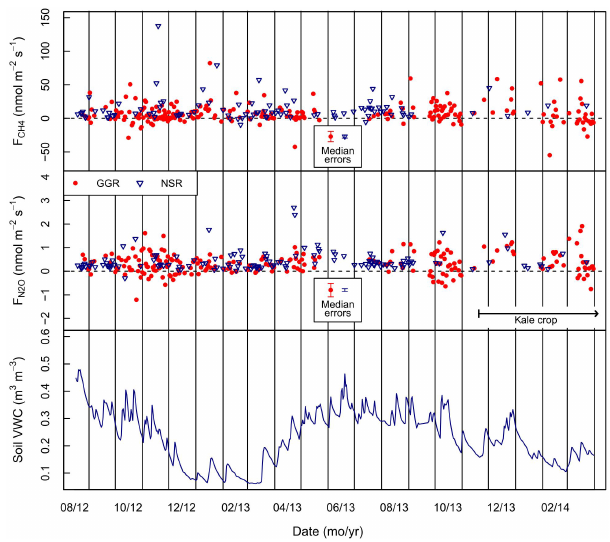
Figure 7. As Fig. 6 but for the UUW site.